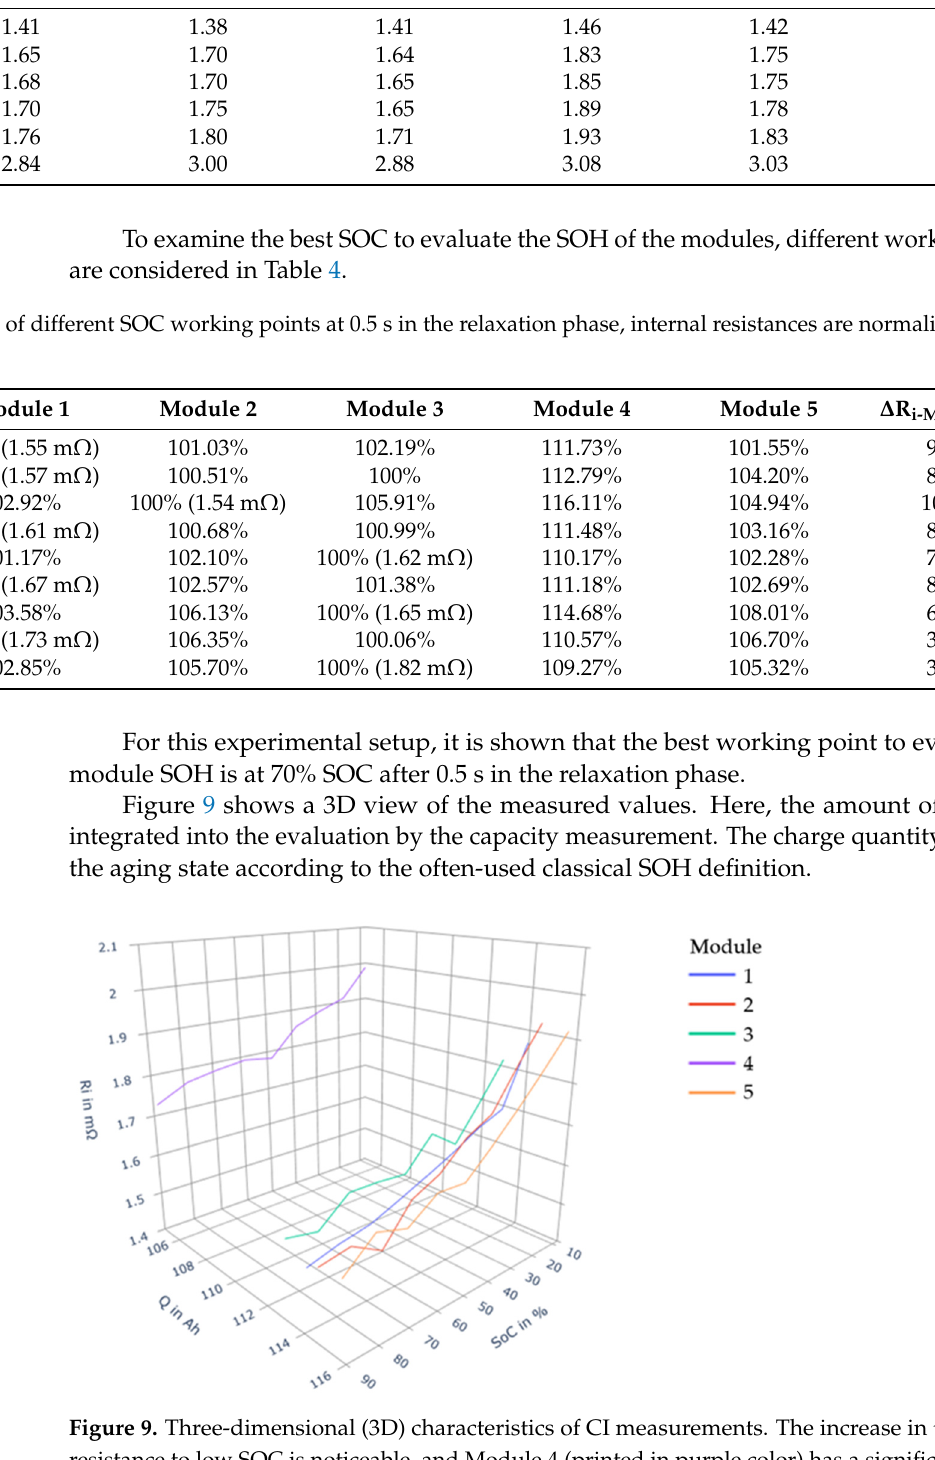
Table 3. Comparison of internal resistances at different time points, measured in the relaxation phase at 30% SOC with the CI method.